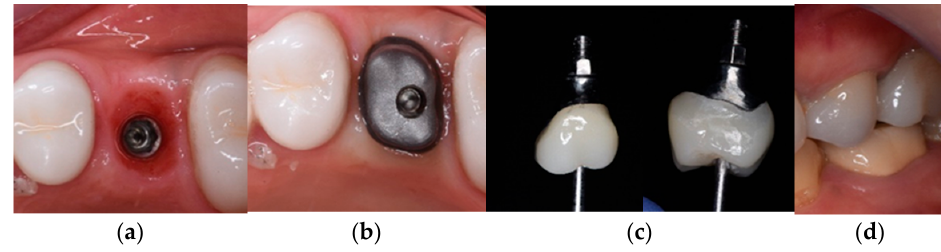
Figure 3. Prosthetic restoration used in Group C.